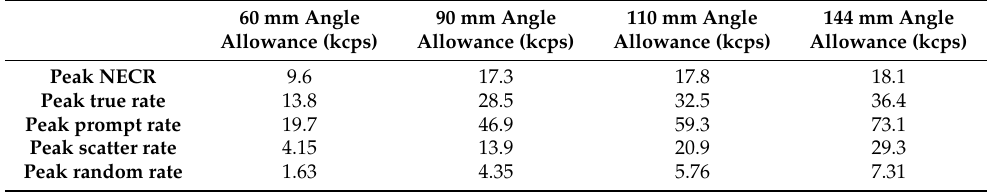
Table 3. Summarized values for count rates at different LOR angle-allowance parameters.